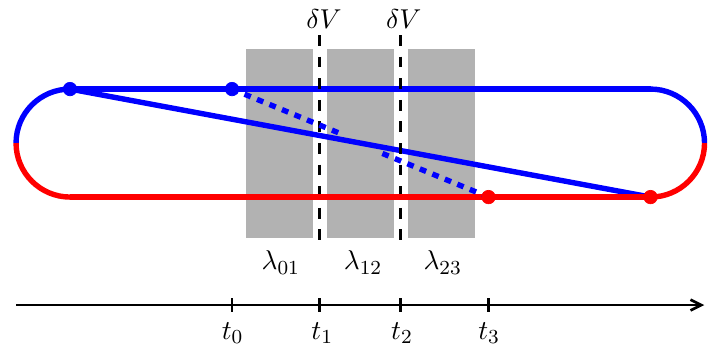
Figure 12 . The analog of figure 9, now for the xy ¯ y ¯ x crossed